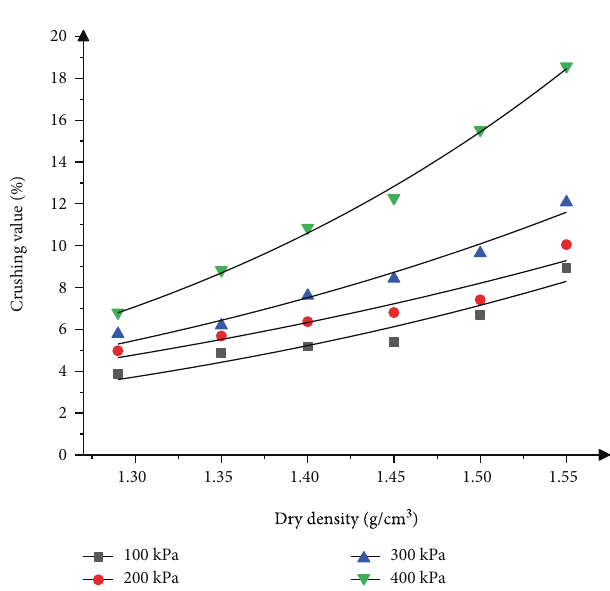
Figure 5: Curve of relationship between crushing value and dry